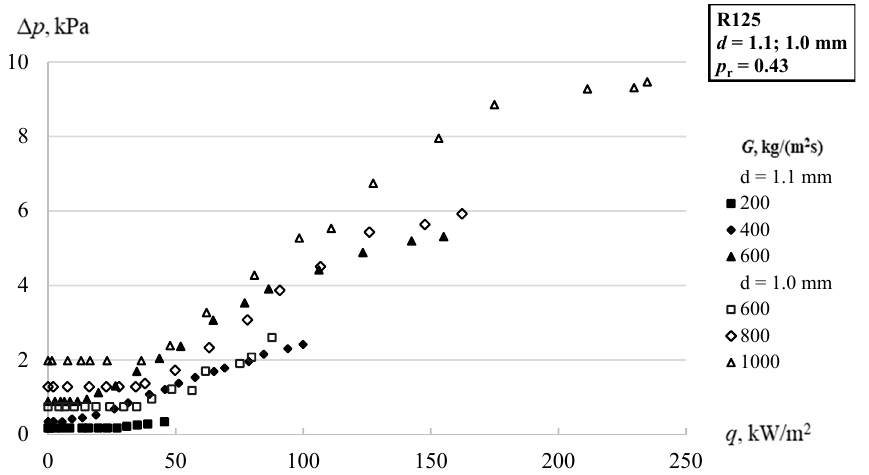
Figure 3. Pressure drop versus heat flux density at various values of the mass flow rates.